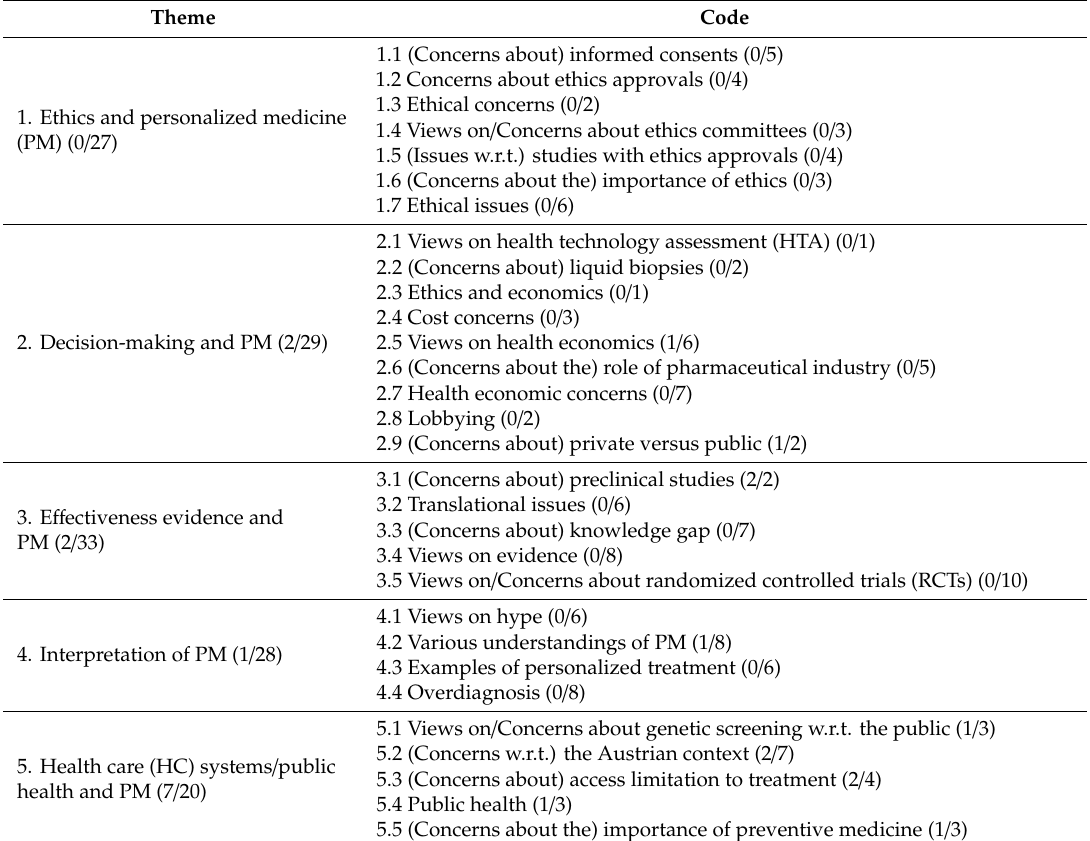
Table 1. Summary of the addressed codes and themes (number of patient / expert responses in